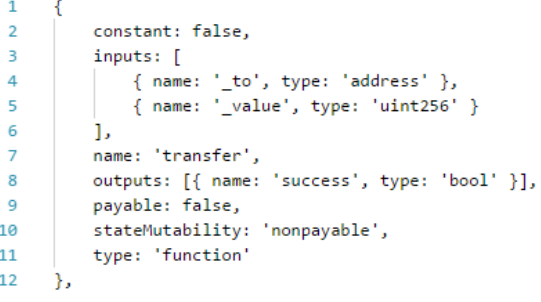
Figure 17. Application Binary Interface (ABI) example of the “transfer” method.